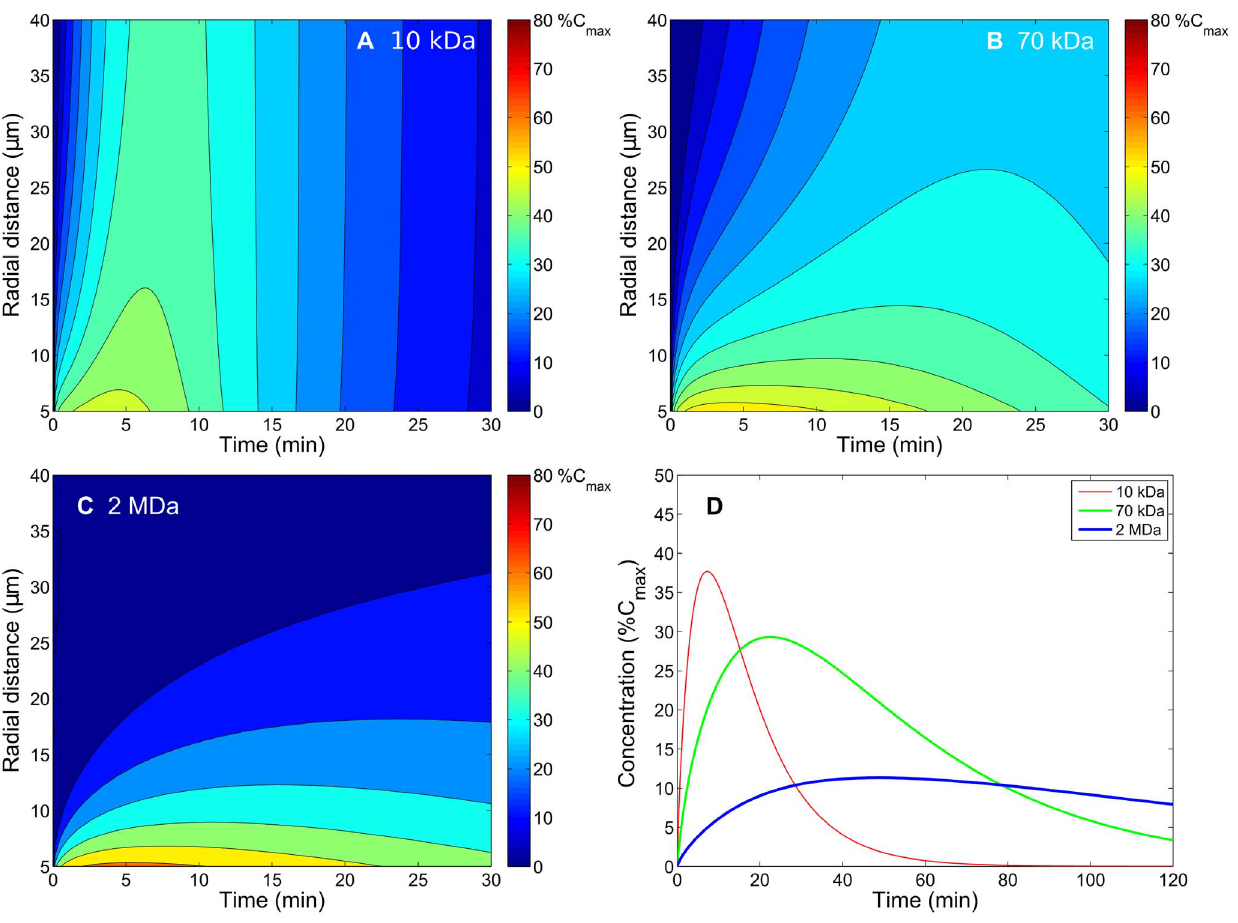
Figure 3. Fitting results of spatiotemporal and spatially averaged concentration responses of macromolecular carriers (dextran). Fitting results of spatiotemporal and spatially averaged concentration responses of macromolecular carriers (dextran) corresponding to molecular weights (A. 10 kDa, B. 70 kDa and C. 2 MDa) in the tumor interstitium with a single blood vessel by tuning the vascular permeability and interstitial diffusivity for each carrier to match [14]. Subfigure D contains a plot through the average concentration for each carrier.